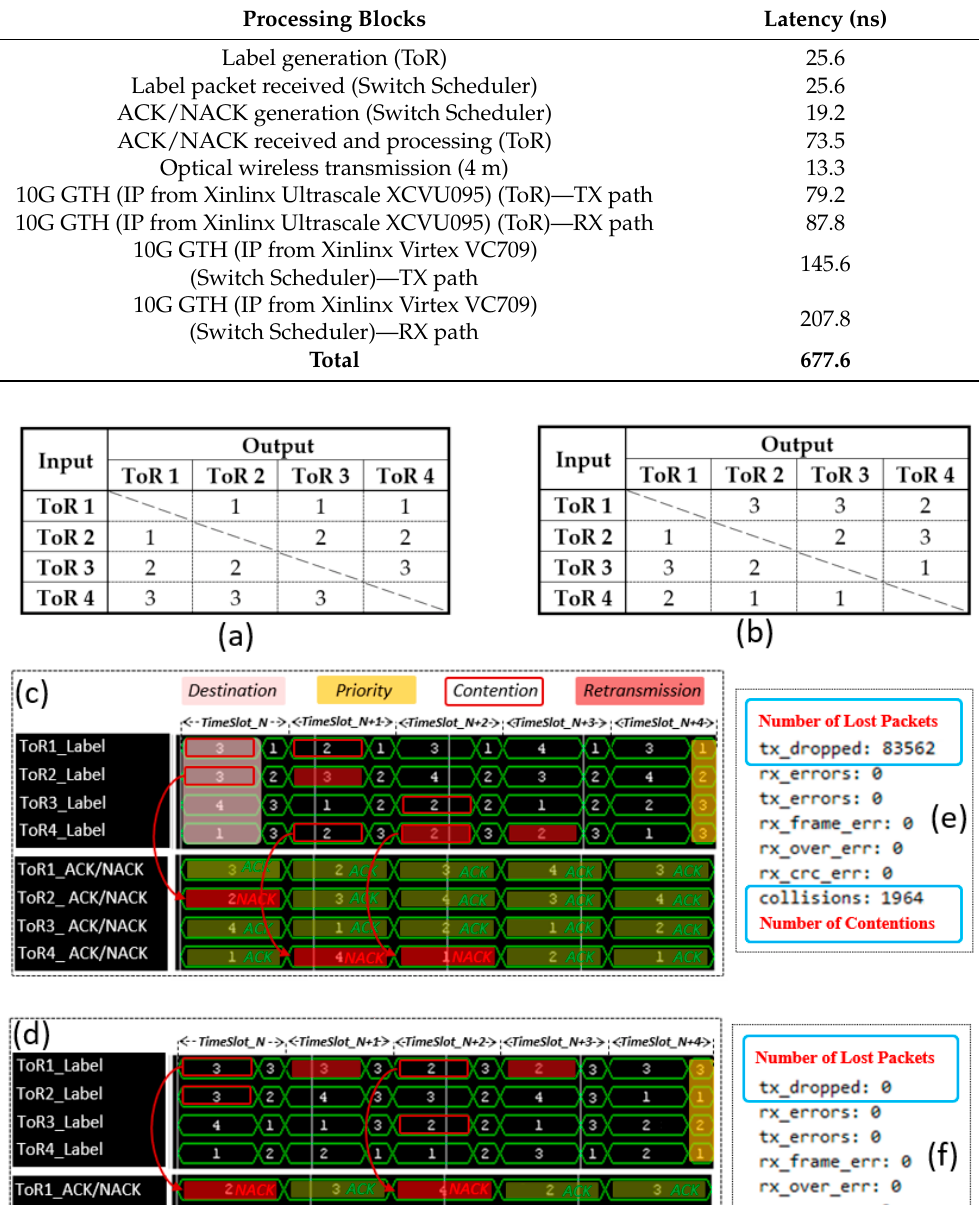
Table 2. The label-processing latency.